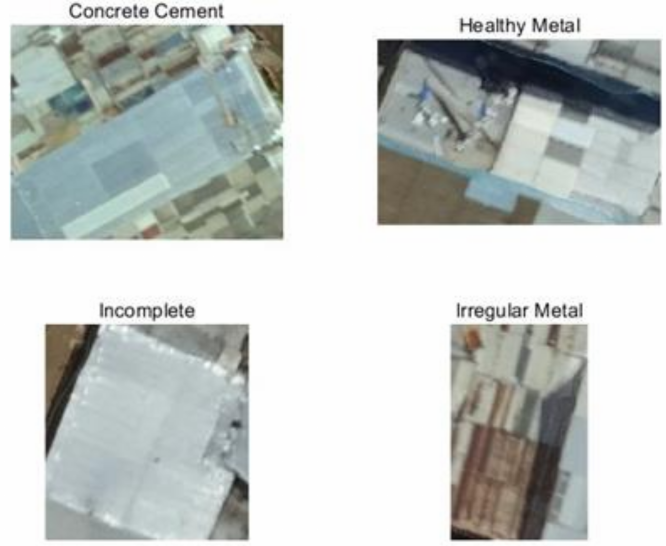
Figure 6. Learning materials for each image.